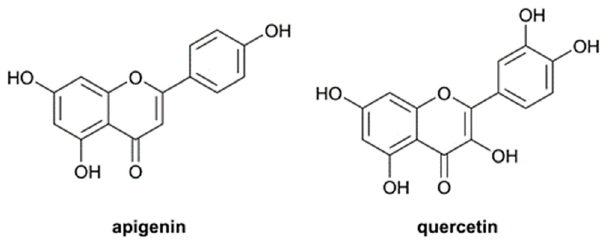
Figure 1. Representations of the chemical structures of apigenin and quercetin.